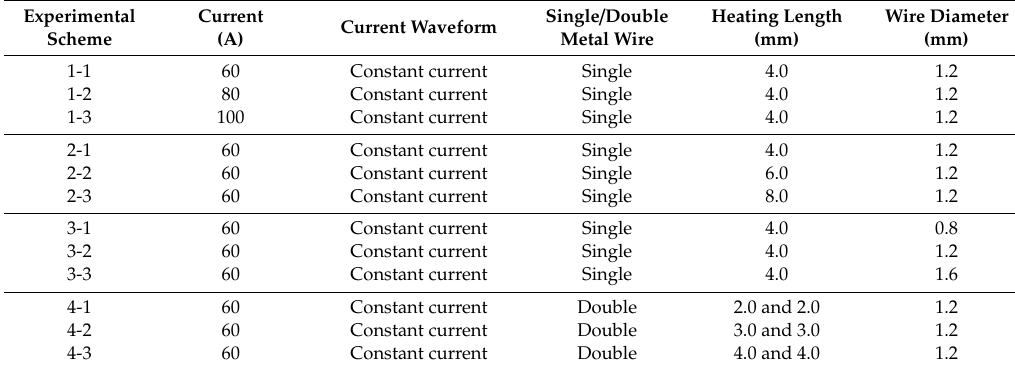
Table 1. Experimental scheme of resistance heating wire.